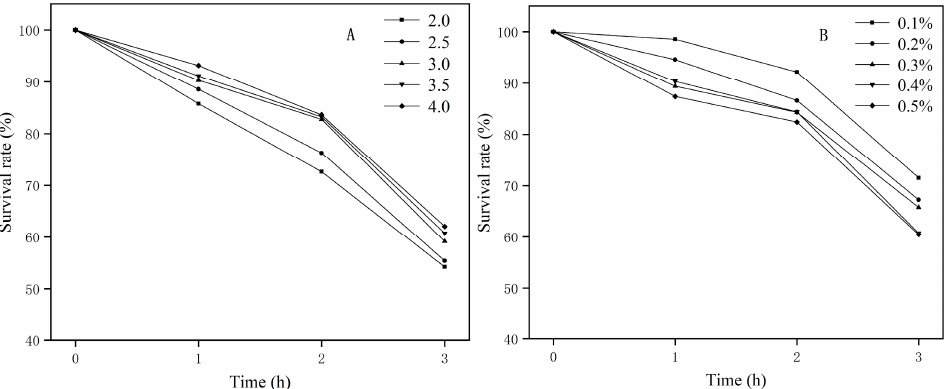
Figure 3. ( A ) Acid resistance test results; ( B ) bile salt resistance test results.